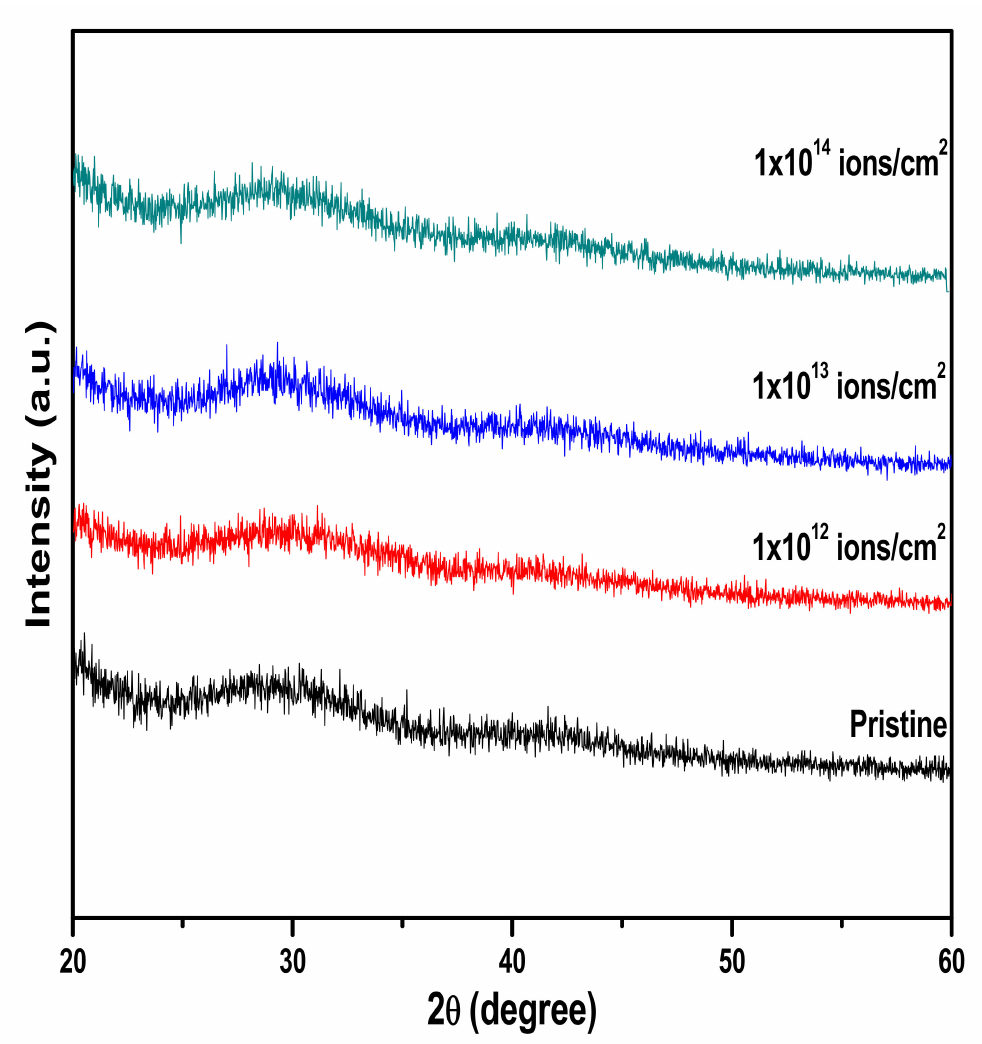
Figure 4. Effect of Cu ion implantation on PMMA using different fluences with a beam energy of 500